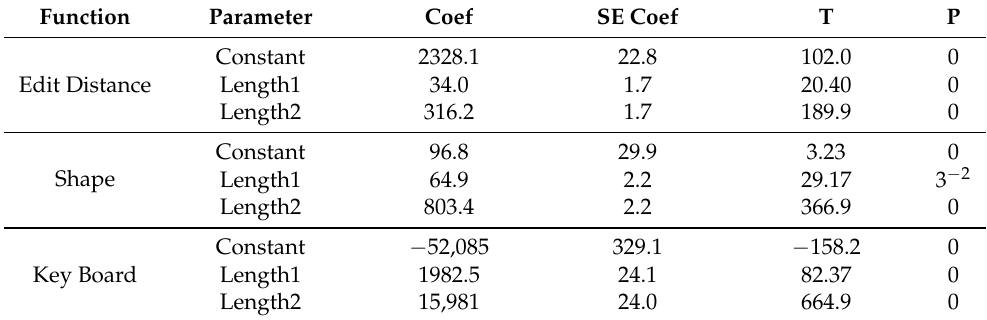
Figure 11. Fragmentation prediction model boxplot. Table 5. Regression statistical analysis